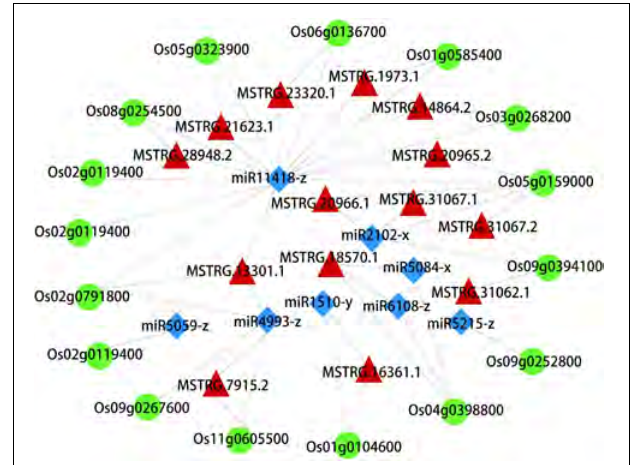
FIGURE 8 | A CeRNA network constructed with DEmRNAs, DElncRNAs, and DEmiRNAs. Green, red, and blue nodes represent mRNA, lncRNA, and miRNA,